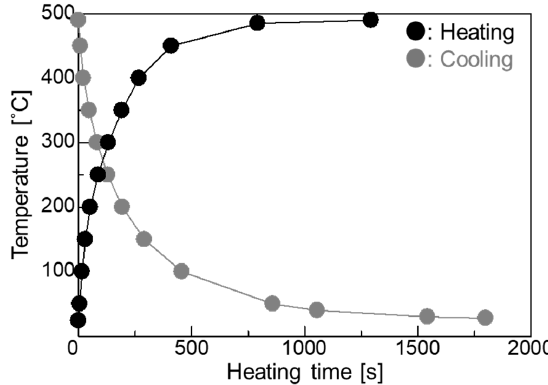
Figure 2. Relationship between heating time and temperature.